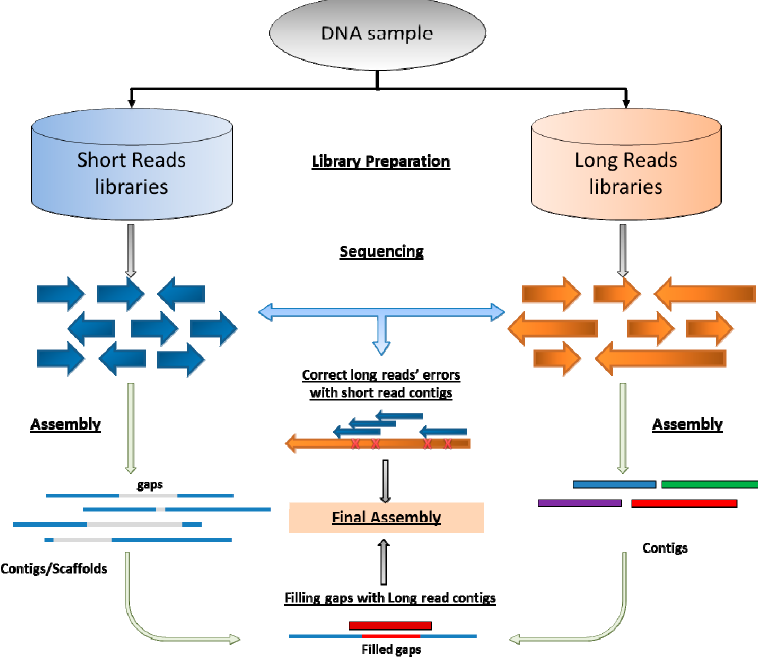
Figure 1. Common flowchart of hybrid assembly to integrate short and long reads. The combination can be at the reads level, i.e. , using short reads to correct the errors in long reads. Alternatively, long reads or their derived contigs could be used as bridges to join or fill-in gaps of contigs assembled with short reads.